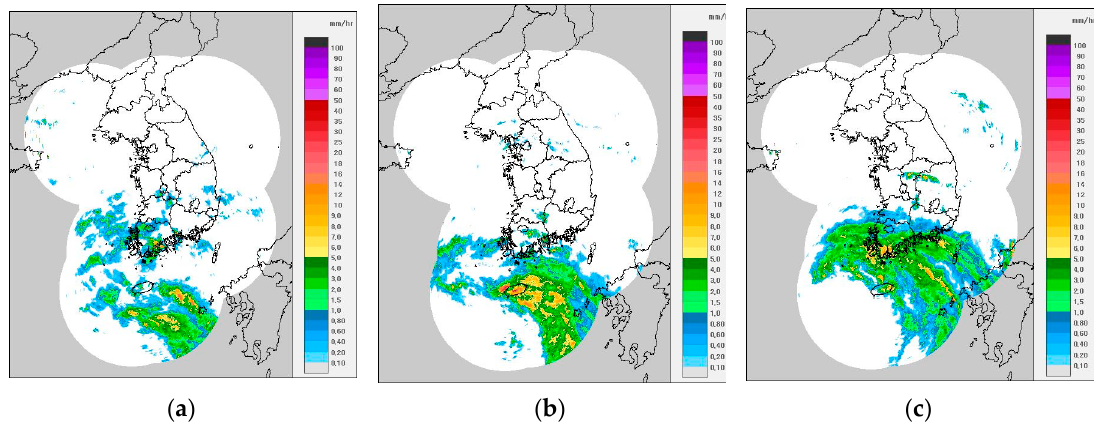
Figure 4. Synthetic radar image around the Korea Peninsula during the Typhoon Nakri in the Jeju Island (2 August 2014). ( a ) 2014/08/02/00:00; ( b ) 2014/08/02/06:00; ( c ) 2014/08/02/12:00.